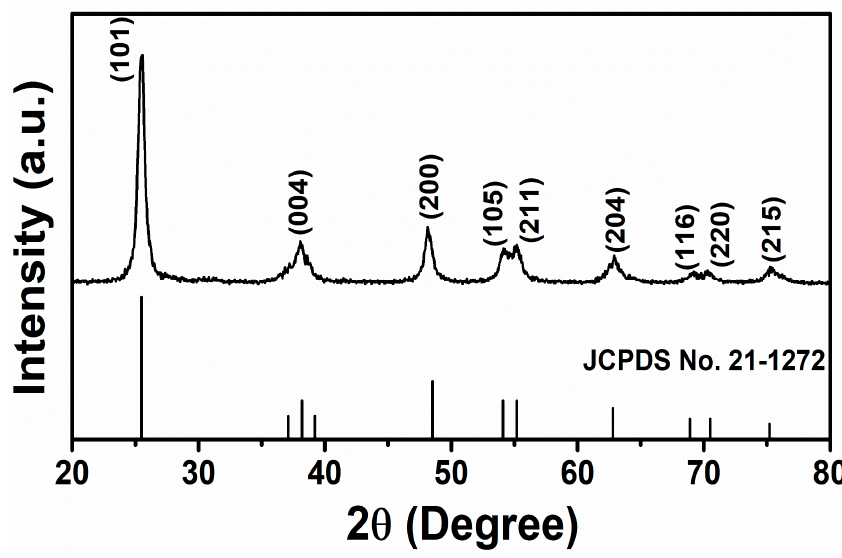
Figure 1. Typical XRD patterns of TiO 2 nanoflowers synthesized by facile low-temperature solution